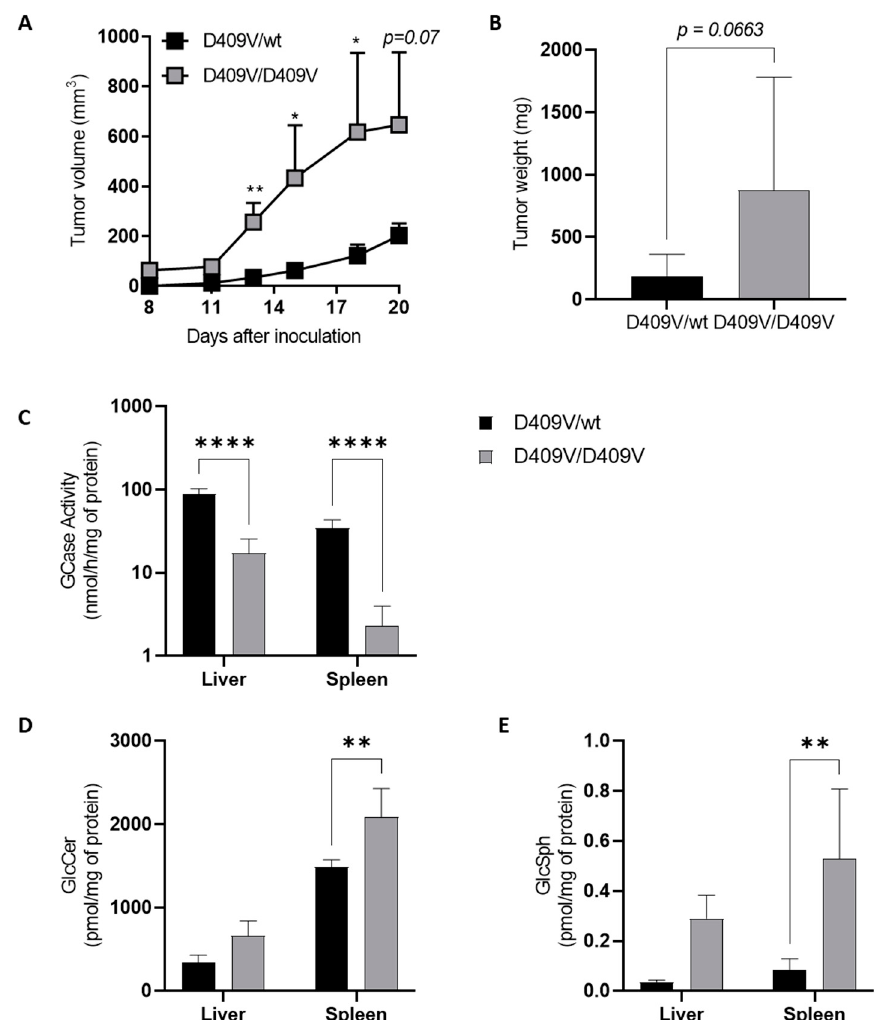
Figure 2. Melanoma tumor growth is increased in a Gba1 D409V/D409V Gaucher mouse model. Murine B16F10 melanoma cells (3 × 10 5 ) were injected subcutaneously into Gba1 D409V/D409V (D409V/D409V) female mice and heterozygous (D409V/wt) littermates having the same mixed genetic background (19–22 weeks of age). ( A ) Tumor volumes were measured every 3 days. ( B ) Tumor weights were measured 25 days after tumor inoculation. Data are expressed as means +/ − SEM of at least two independent experiments (n = 7–21 mice). ( C ) GCase enzyme activity was determined in lysates of liver and spleen isolated from D409V/D409V or heterozygous D409V/wt mice. Assays were performed in duplicate on samples of three to six animals. GlcCer ( D ) and GlcSph ( E ) were extracted by the Bligh and Dyer method [146] from the liver and spleen and analyzed by LC-MS (liquid chromatography coupled by mass spectrometry); assays were performed in duplicate on samples taken at day 20 of three to six animals (18–22 weeks of age). Statistical significance was determined by a Mann–Whitney test. *, p < 0.05; **, p < 0.01; ****, p < 0.0001.